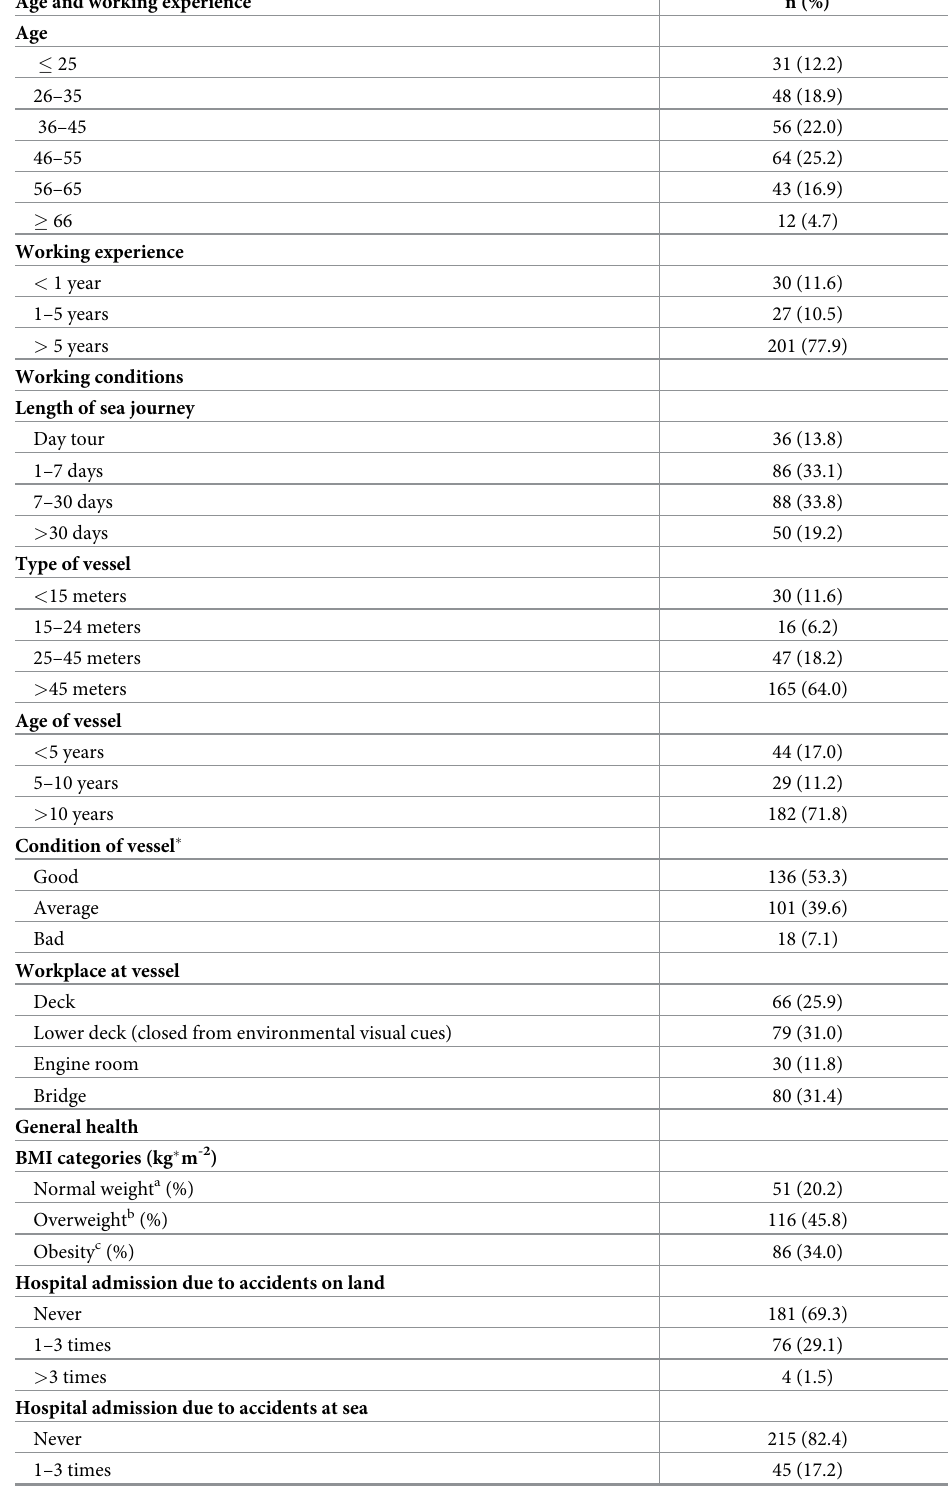
Table 1. Descriptive characteristics on health and work